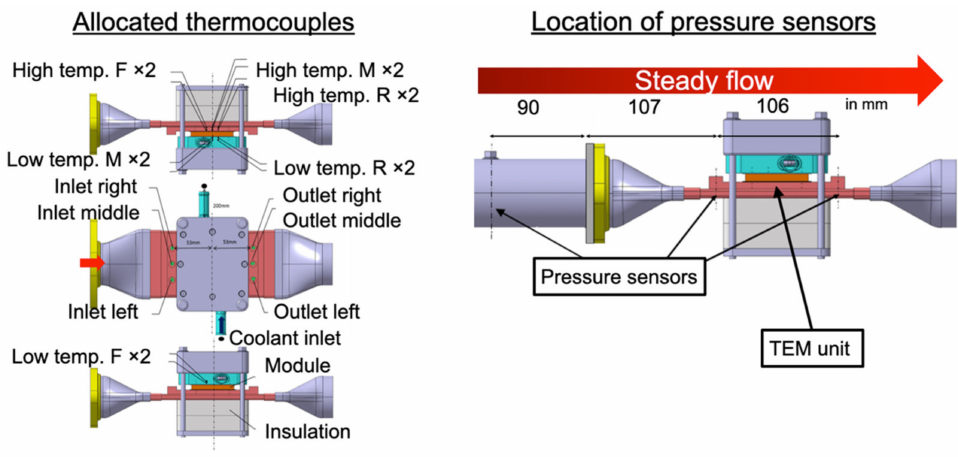
Figure 11. Schematic diagram of the engine exhaust system thermoelectric power generation system test equipment. Corrugated fins are inside the inner wall of the heat exchanger, and 20 thermocouples and 3 pressure sensors are